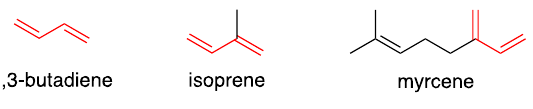
Figure 1. Selected examples of bioactive natural and non-natural 1,3-dienes.